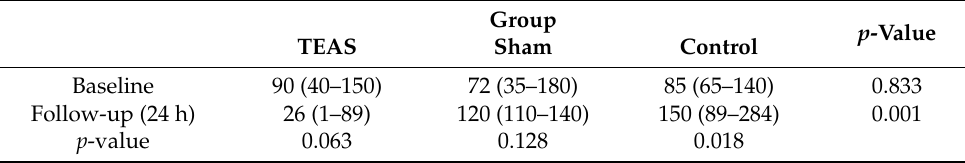
Table 4. Cortisol level (ng/mL) at baseline and at 24 h after the